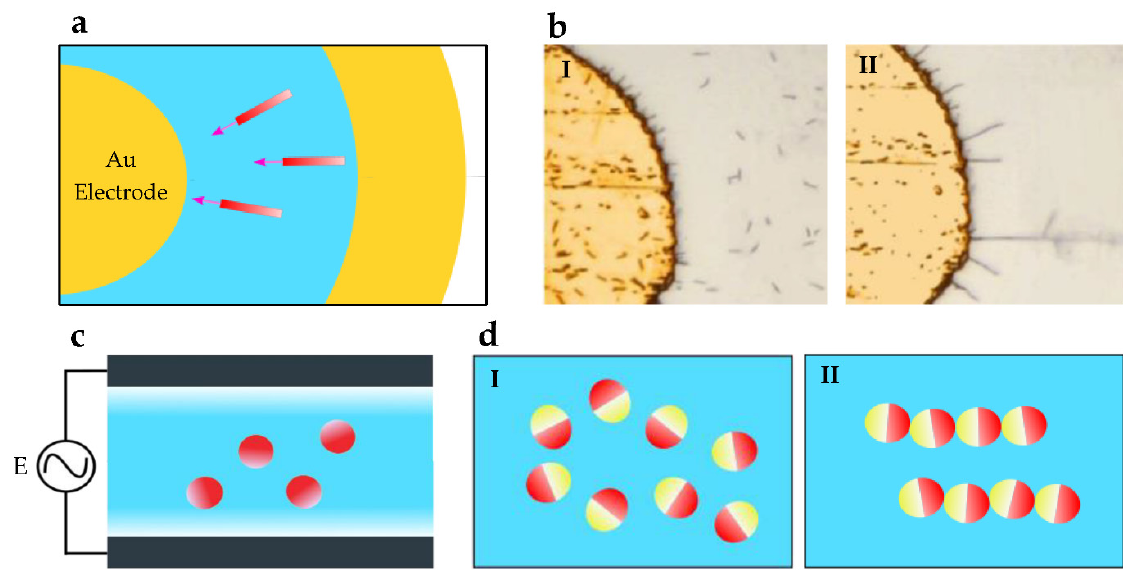
Figure 3. Shape formation techniques using electric fields: (a) Circular electrode nanowire actuation setup. (b) Representative example of randomly distributed nanowires aligning radially under the application of an electric field. Reprinted from [51], Copyright (2011), with permission from Elsevier. (c) An AC electric actuation experimental setup with top and bottom electrodes. (d) Colloids that have metallic and dielectric hemispheres form swarms and chains with varying external frequencies [49].